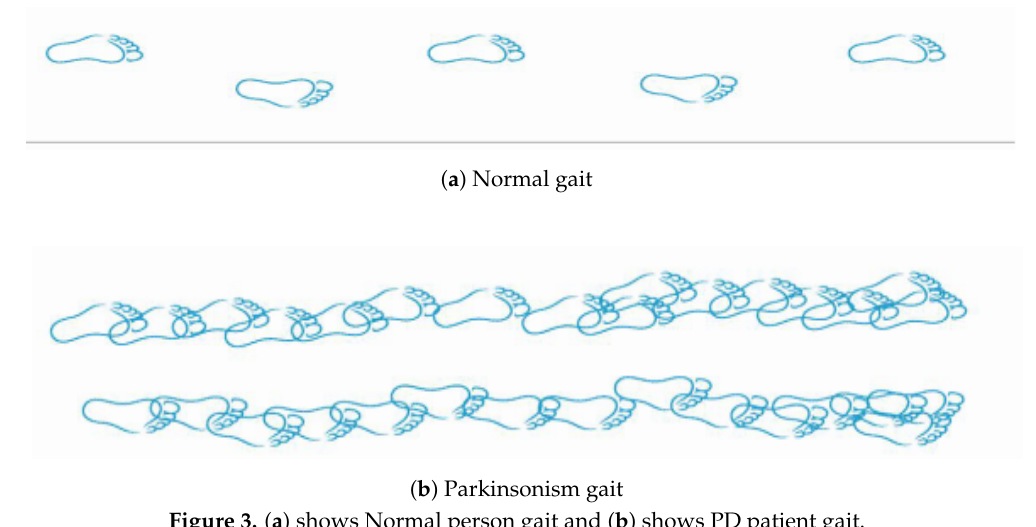
Figure 3. ( a ) shows Normal person gait and ( b ) shows PD patient